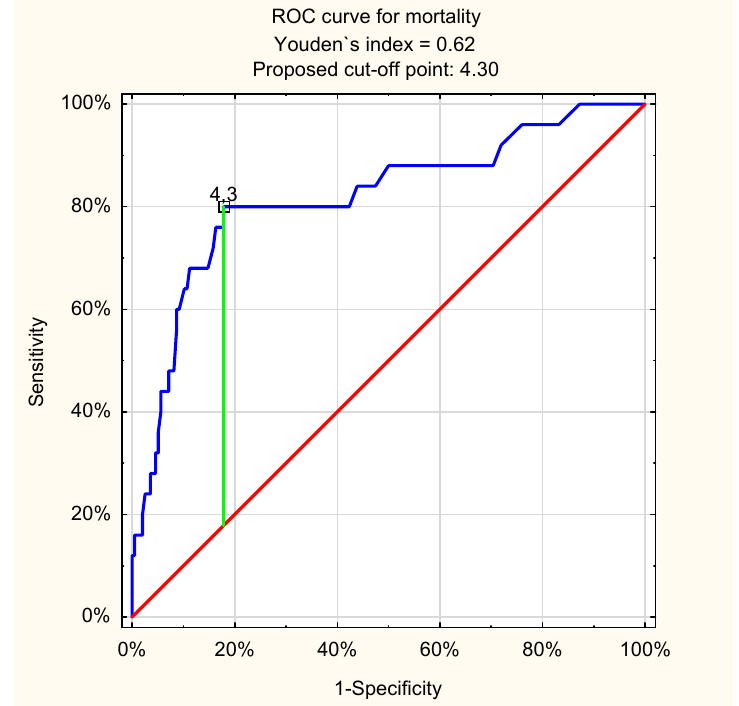
Figure 1. ROC curve for admission venous lactate level and in-hospital mortality in all patients with UGIB (proposed cut-off point = 4.3 mmol/L; sensitivity = 0.80; specificity = 0.82; accuracy = 0.82; AUC = 0.82 (95% CI: 0.72–0.92); p < 0.001).